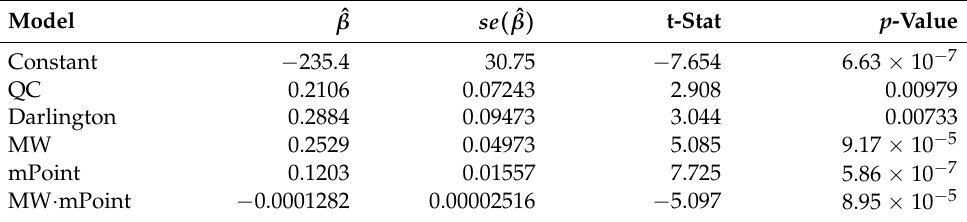
Table 8. Dependent variable: ln(Time)—coefficients for nuclear power plant